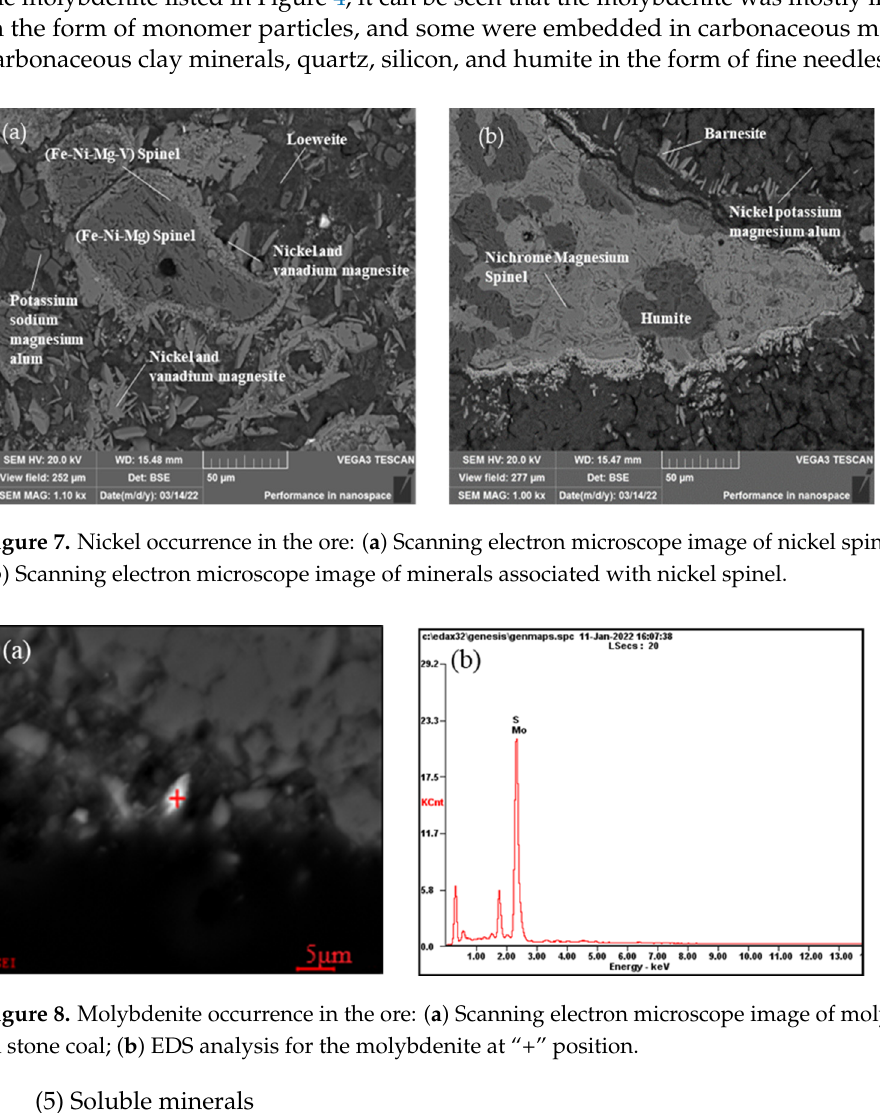
Figure 8. Molybdenite occurrence in the ore: ( a ) Scanning electron microscope image of molybdenite in stone coal; ( b ) EDS analysis for the molybdenite at “+” position.